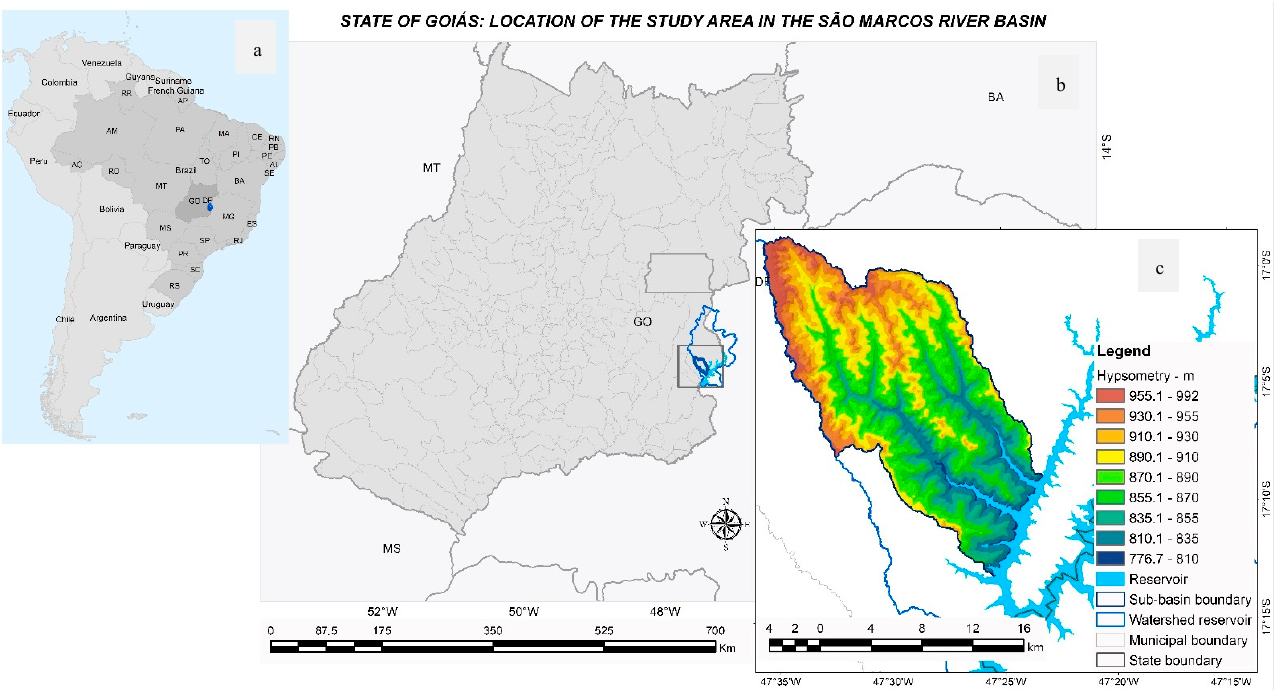
Figure 1. ( a ) Location of Brazil in South America, ( b ) State of Goiás—Midwestern Region of Brazil, and ( c ) right margin of the São Firmino River.